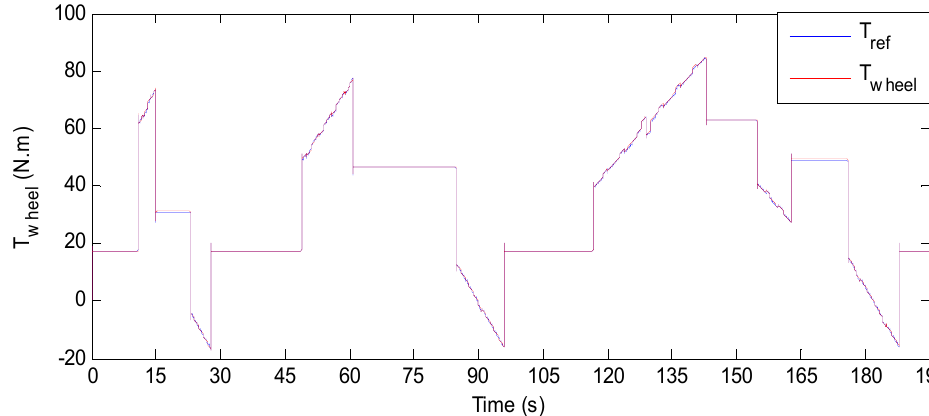
Figure 26. BEV speed absolute error for ECE driving cycle.